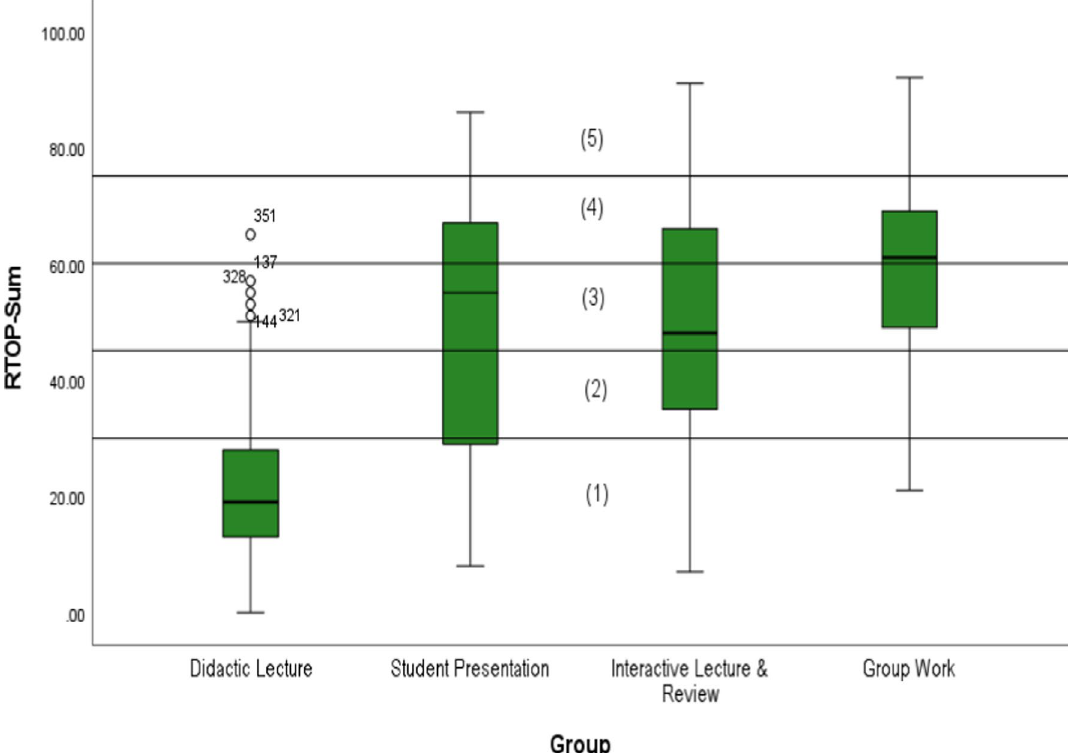
Fig. 5 LPA Group and Distribution of RTOP-Sum Score. Numbers in parentheses correspond to RTOP categories: (1) straight lecture, (2) lecture with some demonstration and minor student participation, (3) significant student engagement with some minds-on as well as hands-on involvement, (4) active student participation in the critique as well as carrying out of experiments, (5) active student involvement in open-ended inquiry, resulting in alternative hypotheses and critical reflection. Boxplot lines mark the mean RTOP score for each